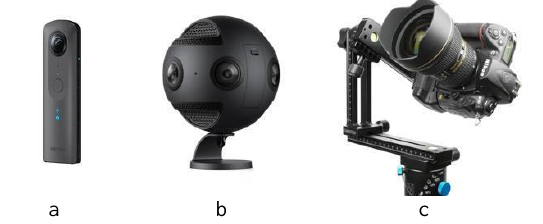
Figure 8: Various panoramic capturing